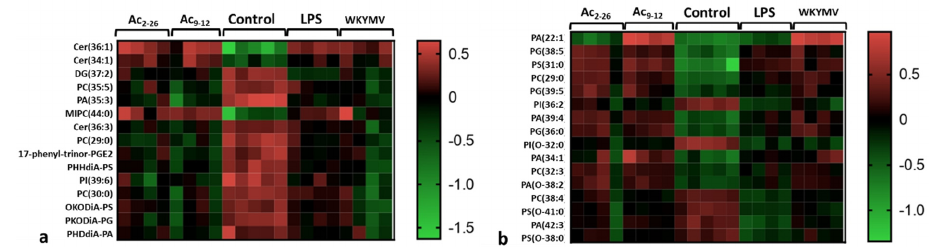
Figure 4. Lipidomic analysis of macrophage lysates. Experimental design: 1 × 10 6 cells were submitted to the followed experimental conditions: control (culture medium); stimulated by LPS (1 µg/mL); pre-treated with Ac 9-12 , Ac 2-26 , or WKYMV (3 µM) and stimulated with LPS; after 24 h, cell lysates were analyzed. Heatmaps show the hierarchical clustering of lipid signatures and demonstrate a different lipid profile between experimental conditions. ( a ) Positive ionization mode. ( b ) Negative ionization mode. Right bars represent the red–green code (from − 1.5 to 0.5) of the lipid abundances.